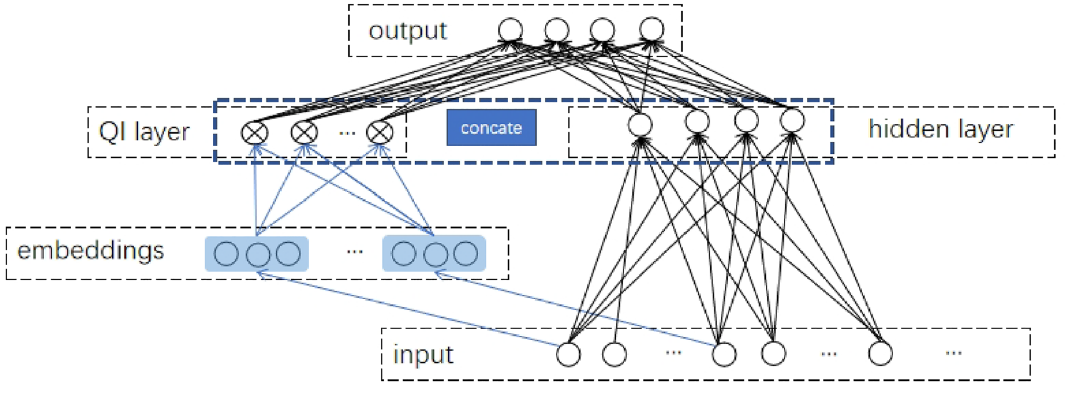
Figure 2. Illustration of